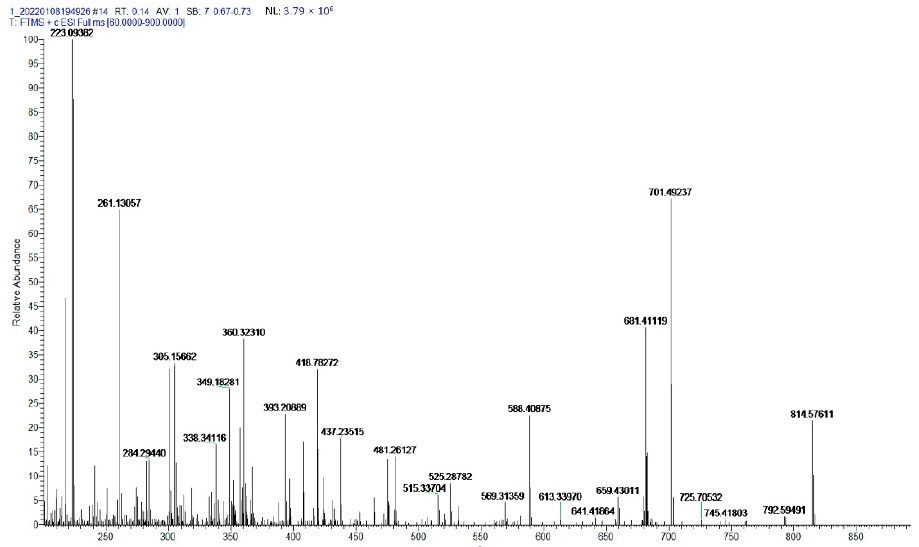
Figure 5. ESI-MS spectra in full-scan mode from m / z 60 to 900 of purified fucoxanthin.